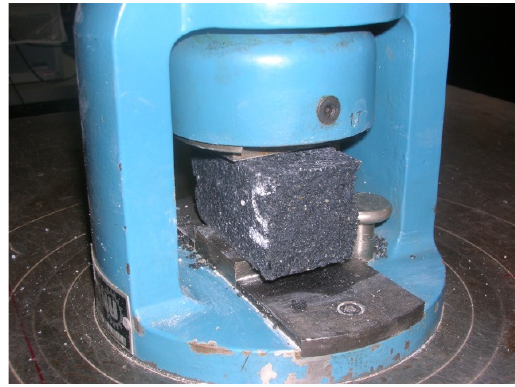
Figure 7: Compressive test on part of the sample coming from flexural